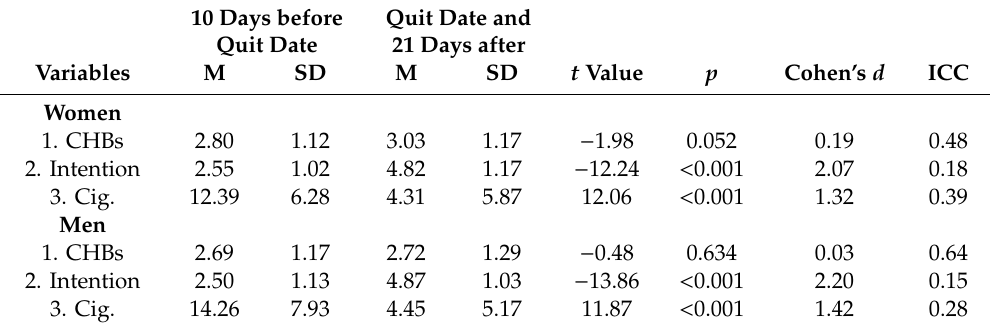
Table 1. Means, standard deviations, t -test comparing 10 days before the quit date and the quit date and 21 days after, e ff ect sizes and intra-class correlations (ICC) of main variables displayed for women and men. 10 Days